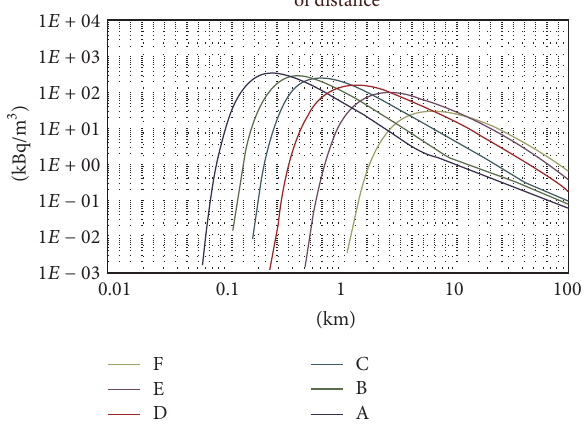
Figure 4: Plume centerline ground deposition of radionuclides as a function of downwind distance in different stability classes (A–F).